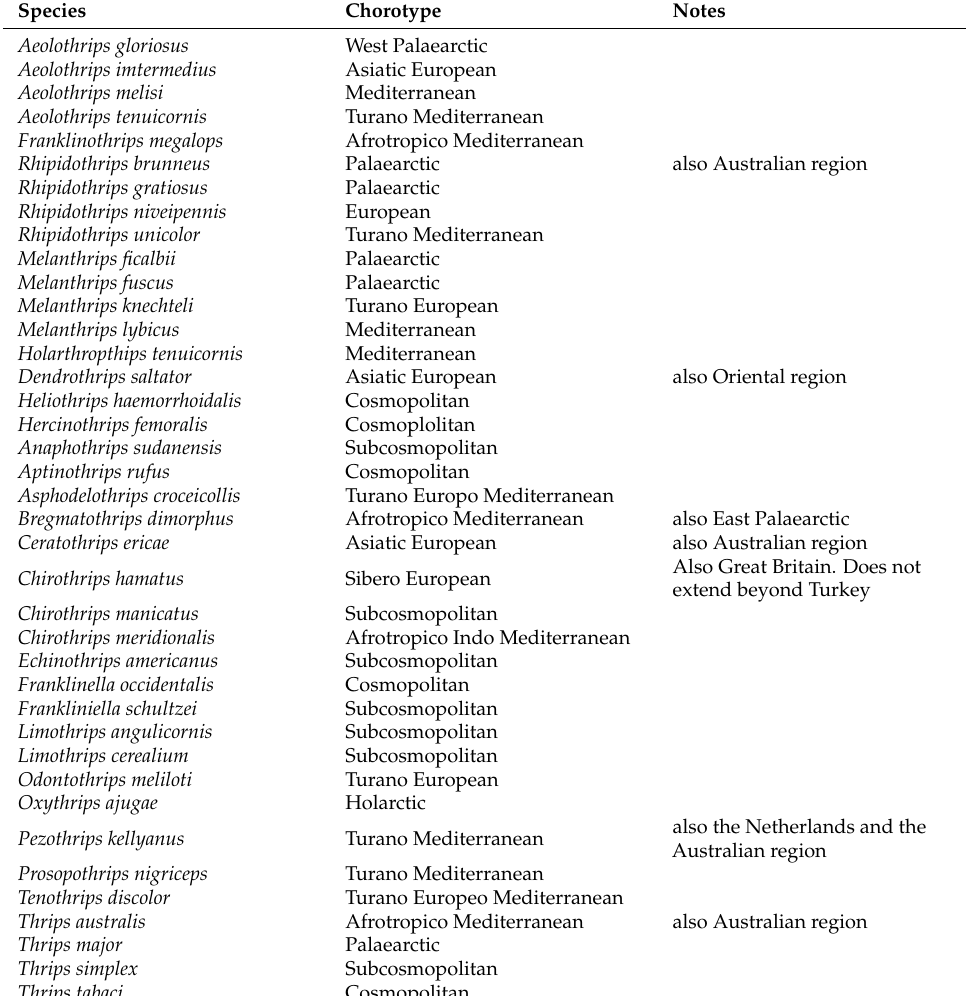
Table A1. Chorotypes for the Thysanoptera of the Maltese Islands (based on data from previously published